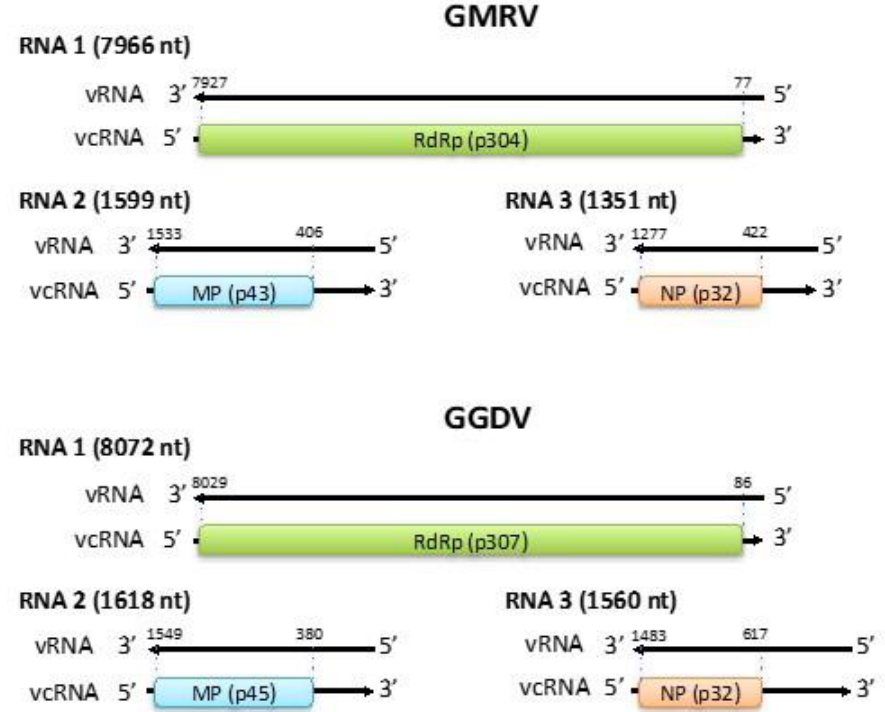
Figure 1. Genome organization of grapevine Muscat rose virus (GMRV) and grapevine Garan dmak virus (GGDV). vRNA, viral RNA; vcRNA, viral complementary RNA; RdRp, RNA-dependent RNA polymerase; MP, movement protein; NP, nucleocapsid protein. Nucleotide positions with respect to the vRNA are reported.